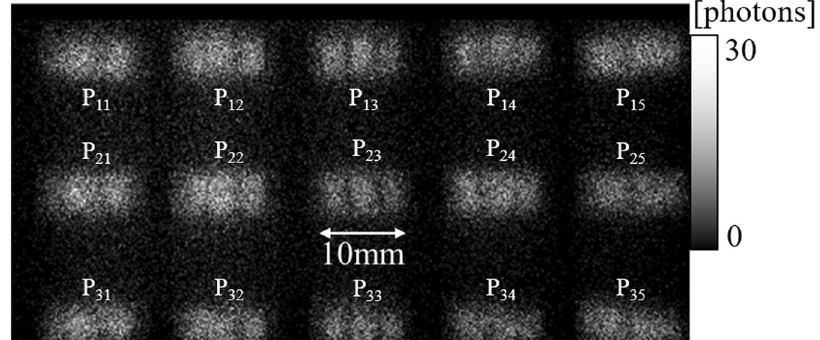
Figure 8. Projections of Phantom (I).